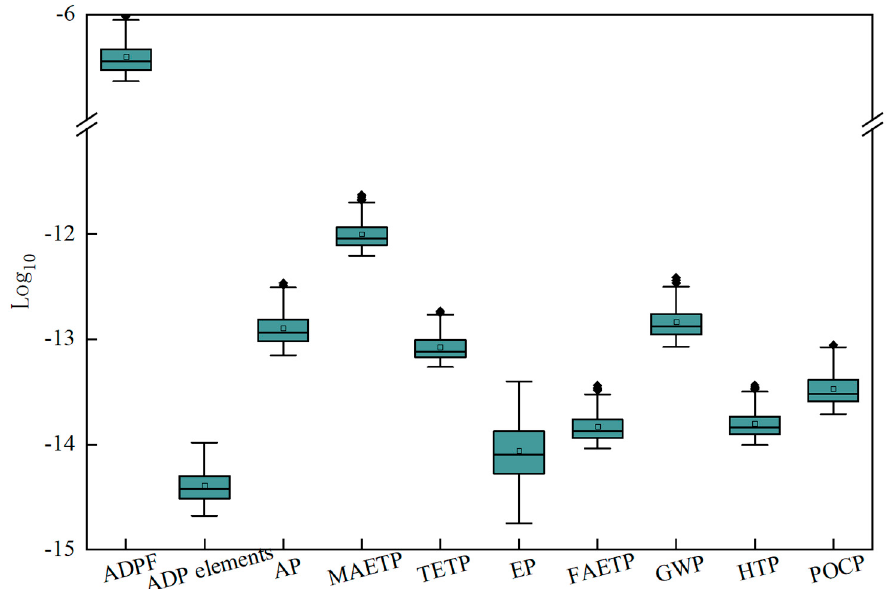
Figure 5. Normalization results of community-based rainwater utilization. (EP: eutrophication potential; FAETP: freshwater aquatic ecotoxicity potential; POCP: photochemical ozone creation potential; ADP elements: abiotic depletion potential elements; AP: acidification potential; TETP: terrestrial ecotoxicity potential: global warming potential; HTP: human toxicity potential; ADPF: abiotic depletion potential for fossil fuels; MAETP: marine aquatic ecotoxicity potential).